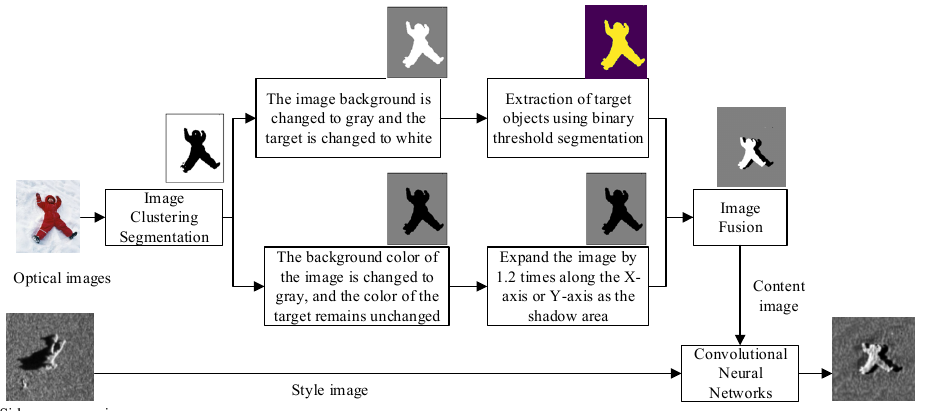
Figure 3. Synthesis process of “simulated side-scan